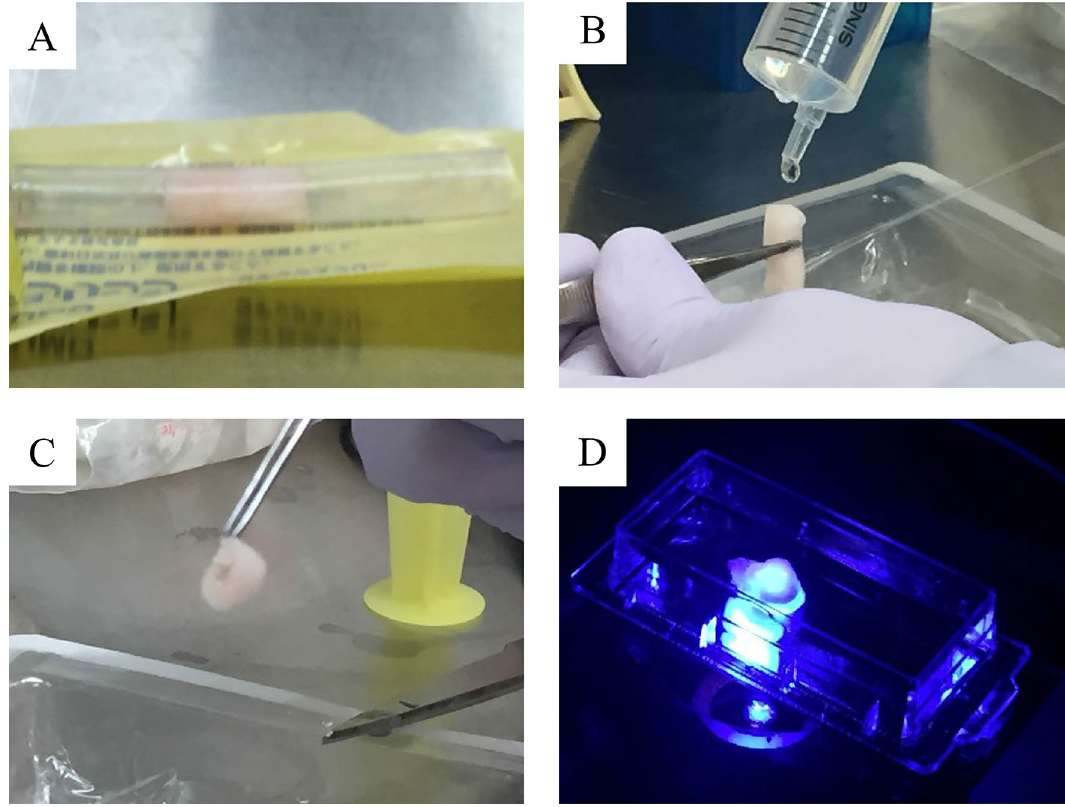
Figure 7. Matured blood vessels after training in the bioreactor. The tubular shape could be retained without much damage by some experimental procedures. ( A ) Extraction, ( B ) Washing with PBS, ( C ) Cutting/Slicing, ( D ) Observation.